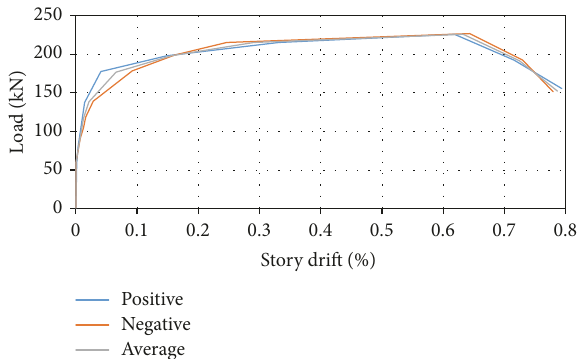
Figure 16: Effect of torsion produced in the form of diaphragm rotation in nonretrofitted block masonry